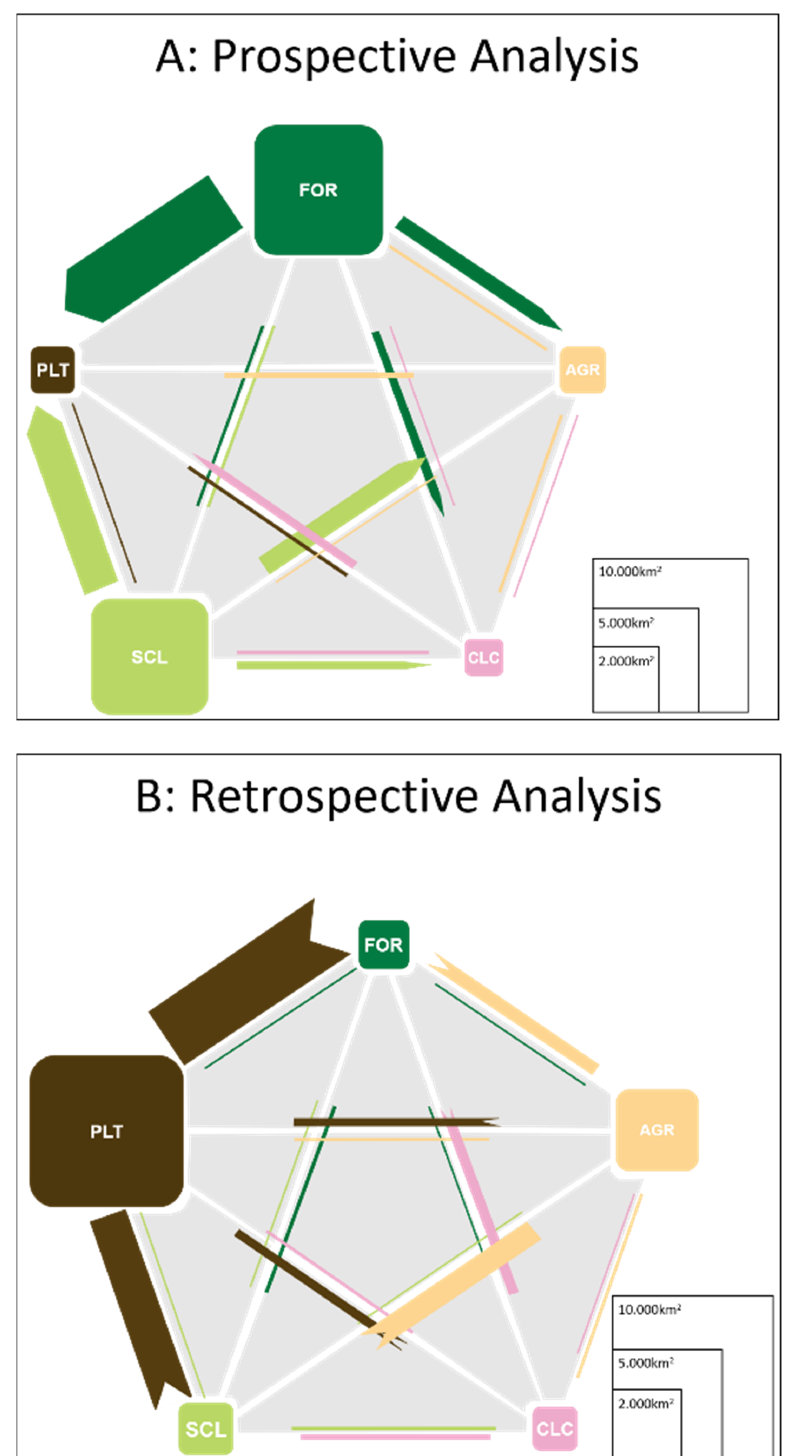
Figure 5. Land use transitions. ( A ) Prospective analysis. Size of squares is proportional to the amount of land use of a particular type in 1975; width of lines is proportional to the amount of land use converted into another land use system in 2010. ( B ) Retrospective analysis. Size of squares is proportional to the amount of land use of a particular type in 2010; width of lines is proportional to the amount of land use taken from another land use system in